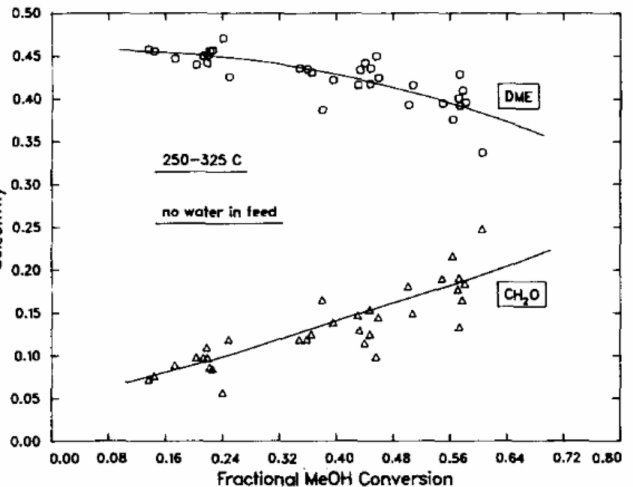
Figure 44. DME and FA selectivity as function of MeOH conversion over Fe 2 (WO 3 ) 3 . Reprinted from [229] Copyright © (1985), with permision from